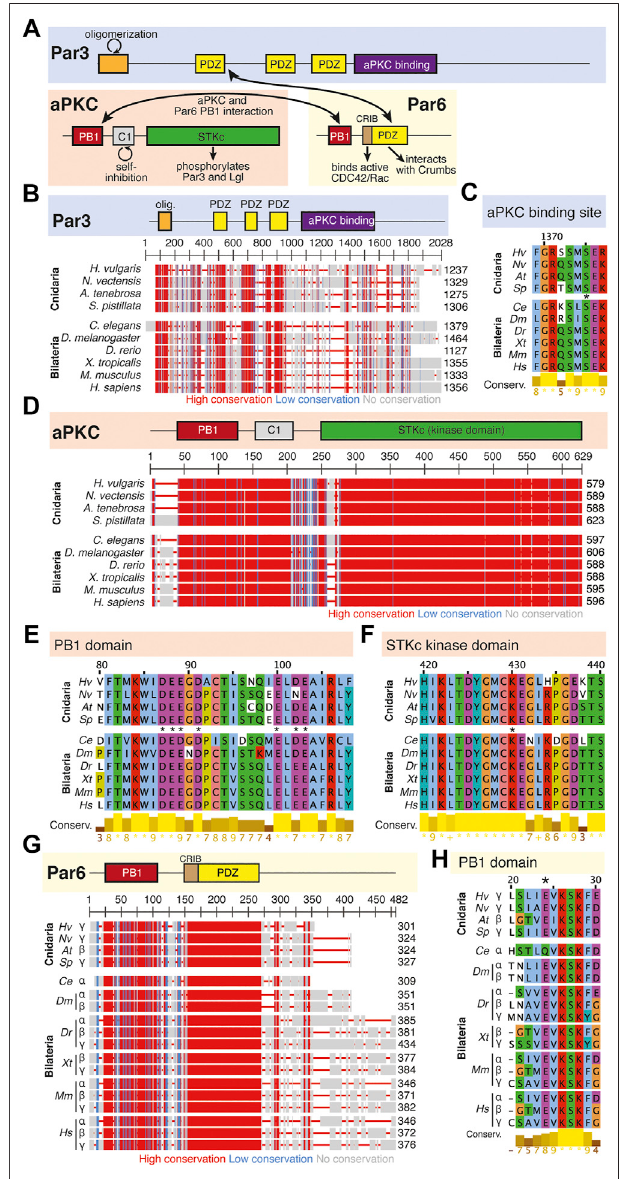
FIGURE 3 | The Par complex de fi nes the subapical domain and is conservedacrossbilateriansand cnidarians. (A) Representationofthehuman Par complex with Par3, Par6, and aPKC pictured. Functional domains and examples of protein-protein interactions denoted. (B) Full protein alignment of Par3 with functional domains depicted in their respective positions. (C) Amino acid alignment of the aPKC binding region of Par3. (D) Full protein alignment of aPKC with functional domains depicted in their respectivepositions. (E-F) AminoacidalignmentofaPKCPB1domain(E)and STKckinasedomain(F).Criticalresiduesmarkedwithasterisk. (G) Fullprotein alignment of Par6 with functional domains depicted in their respective positions. (H) Amino acid alignment of Par6 PB1 domain. Critical residues marked with asterisk. For all alignments: COBALT used for all protein alignments.High(red),low(blue),andnoconservation(gray)regionsdenoted. FASTA sequences from COBALT visualized using JalView for amino acid alignments. Hydrophobic (blue), positively charged (red), negatively charged (magenta), aromatic (cyan), and polar (green) amino acids denoted by color, as well as cysteines (pink), glycines (orange), prolines (yellow). Conservation ( Continued